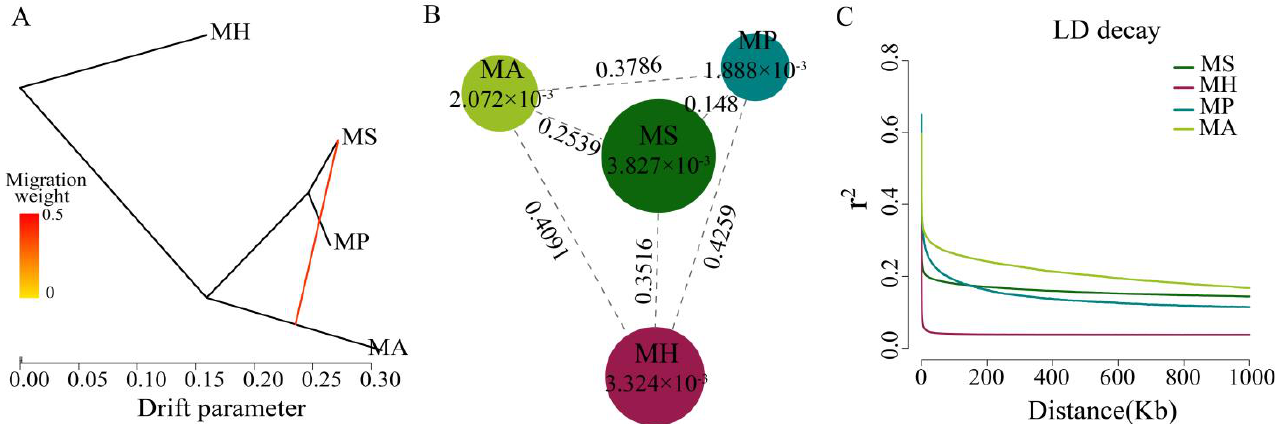
Figure 3. Population genetic analysis of Megalobrama species. ( A ) Gene flow analysis of Megalobrama species. Arrows indicate migration events that occur between populations. The heat map indicates migration weight. ( B ) Nucleotide polymorphism ( π ), and differentiation index (Fst) of the four Megalobrama species. The largest circle represents the large π value, and the longer line segment represents the large Fst value. MH refers to M. hoffmanni , MA to M. amblycephala , MS to M. skolkovii , MP to M. pellegrini . ( C ) Decay of linkage disequilibrium (LD) patterns for the four Megalobrama species inferred by the phylogenetic trees.